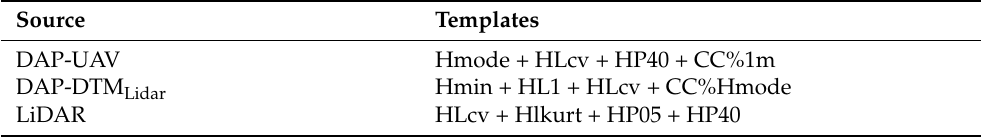
Table 10. Best models to estimate average dbh from DAP-UAV, DAP-DTM LiDAR , and LiDAR.